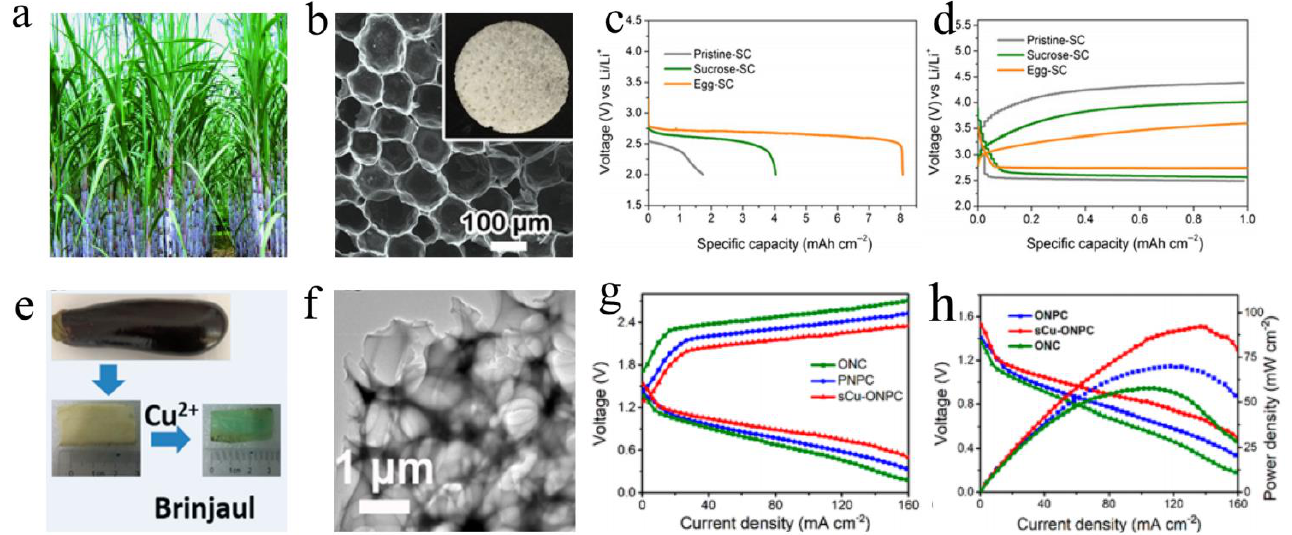
Figure 6. Biochars with self-standing structure being cathode materials for metal–air batteries; SEM image of biochars, electrochemical performance curves. ( a – d ) Sugarcane. Adapted with permission from ref. [44]. Copyright 2019, American Chemical Society. ( e – h ) Brinjaul. Adapted with permission from ref. [122]. Copyright 2019, American Chemical Society. Table 2. Biochar with self-standing structure being binder-free cathode for metal – air batteries.